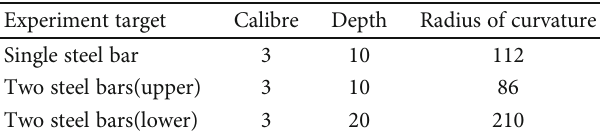
Figure 7: According to the equation image of curve fi tting in Figure 4(b). Table 6: Calculation result of the fi tting